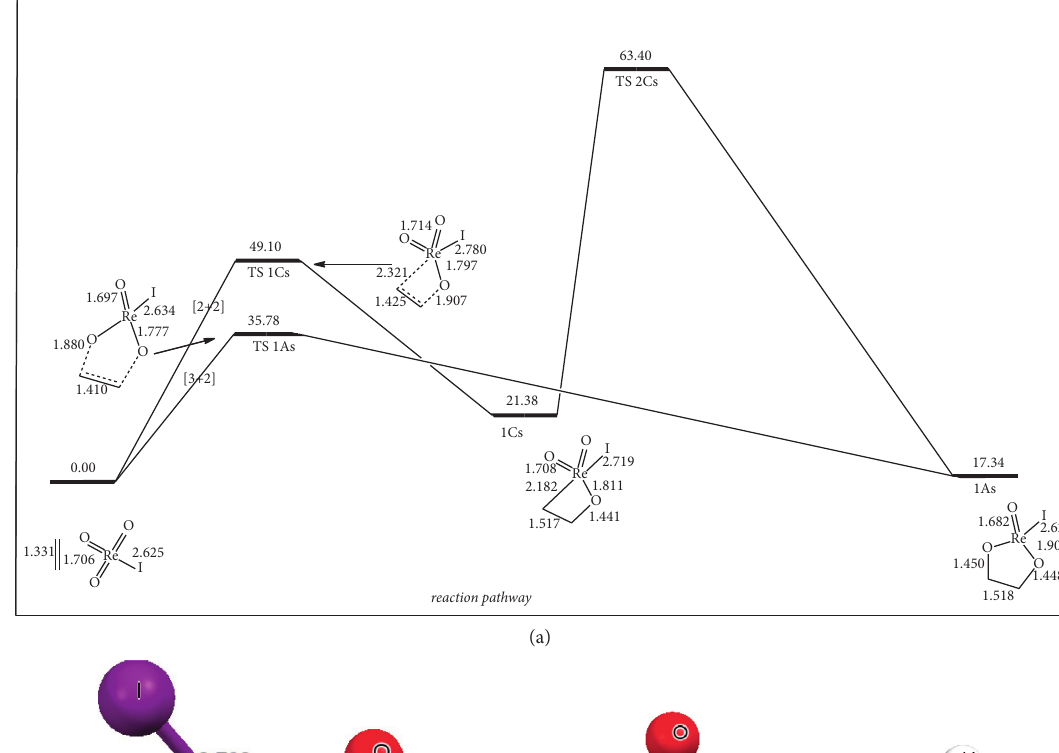
∗ level of theory. (b) 3 I and ethylene at the B3LYP/LACVP